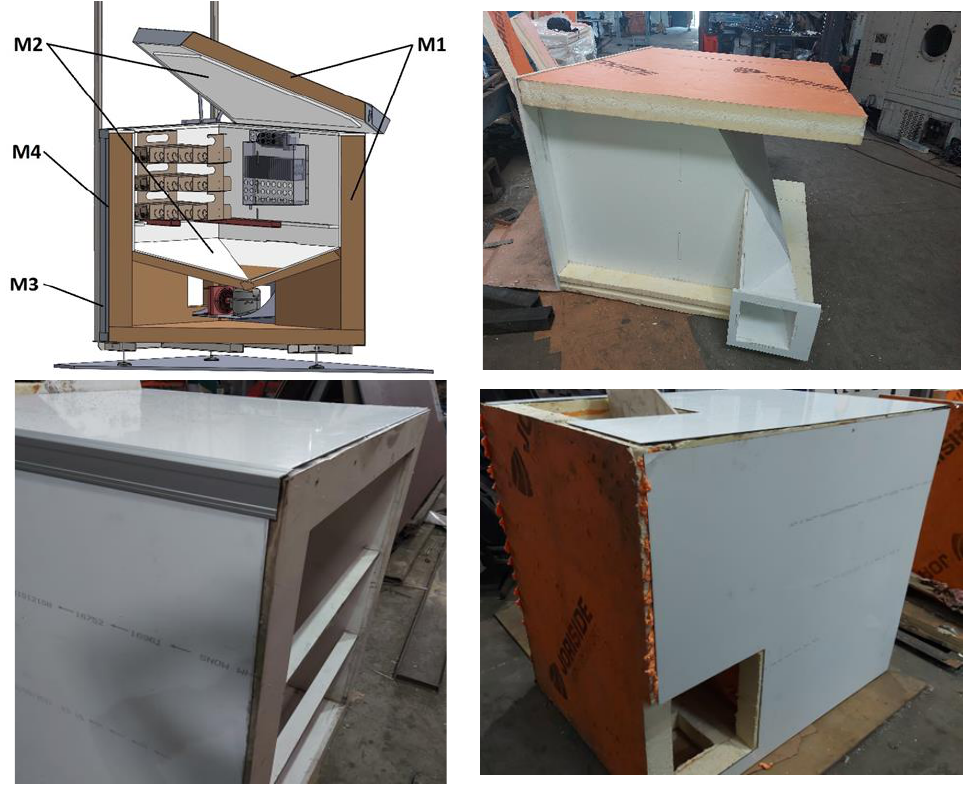
Figure 3. 3D model and manufacturing of the thermally insulated enclosure . M1 — Termoconfort; M2 — Komacel; M3 — perimeter protection profiles; M4 — Bond PE . M2—Komacel; M3—perimeter protection profiles; M4—Bond